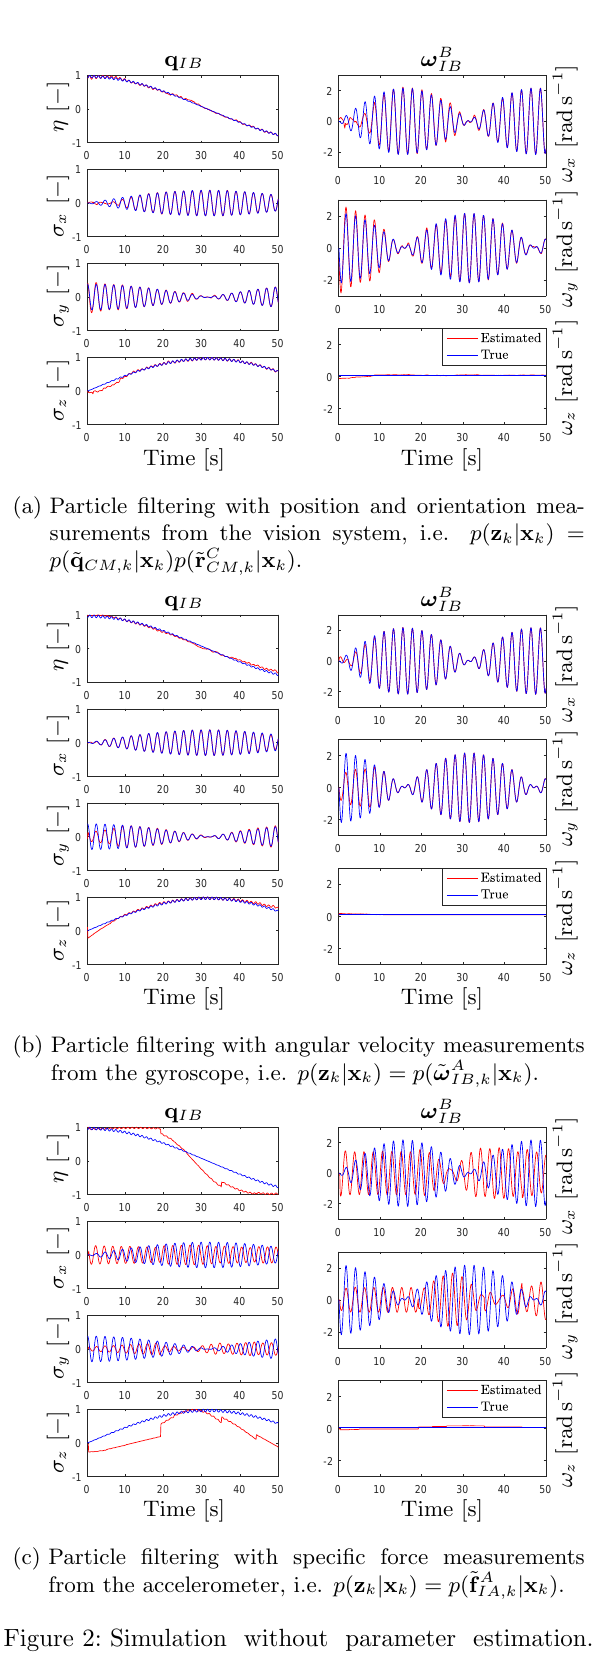
Figure 2: Simulation without parameter estimation. The plots show the particle filter